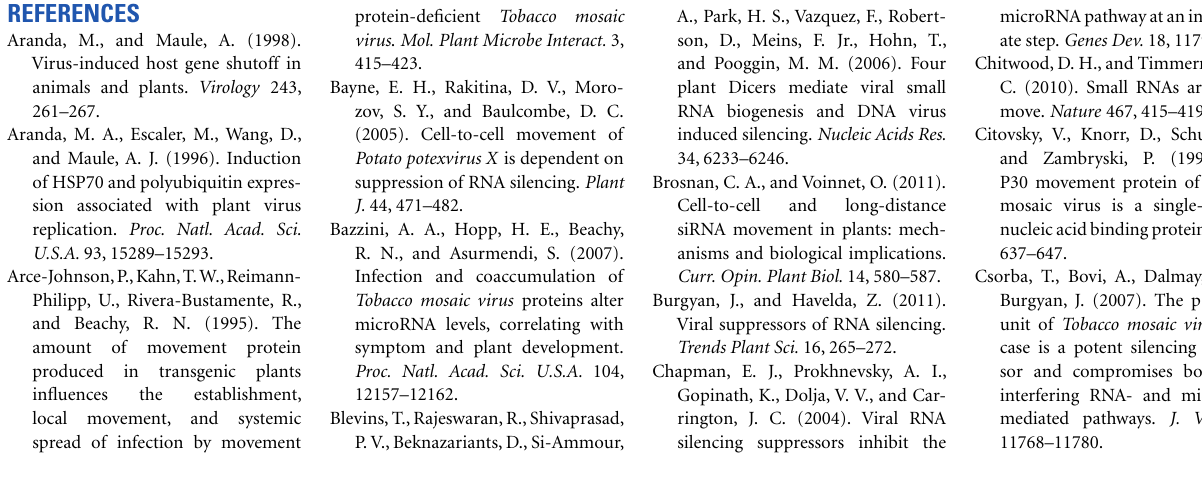
FIGURE 4 | Proposed time-resolved model forTMV infection. Cells at the leading front of infection sites (middle cell) undergo initial stages of infection. The virus induces the biogenesis of vsRNAs and specific host sRNAs. In these cells,VSR levels are still low and vsRNAs and host sRNAs can be loaded into RISC to guide translation repression and cleavage of the virus and of specific host transcripts. In these cells, MP acts at very low concentration to transport vsRNAs, host sRNAs and viral RNA into non-infected cells.The vsRNAs and host sRNAs can program RISC to manipulate the expression of